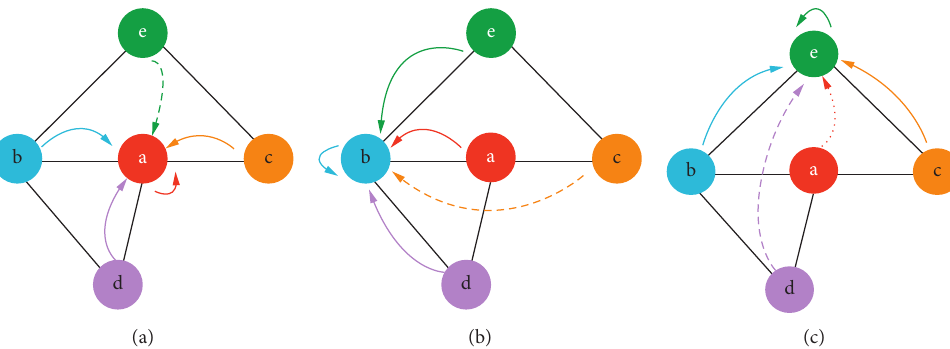
Figure 3: The process of GCN performing a convolution operation. (a) Convolution process of node A. (b) Convolution process of node B. (c) Convolution process of node E.